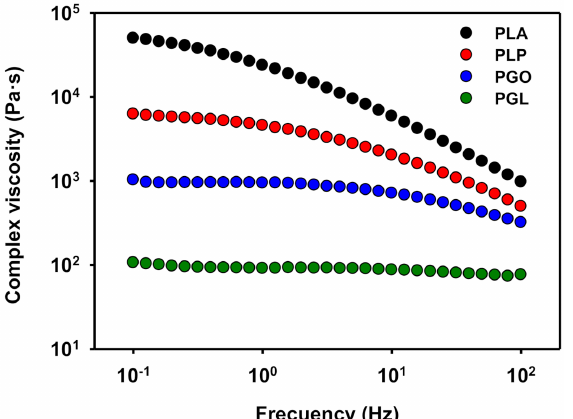
Figure 10. Representation of complex viscosity at 130 ◦ C for PLA, PLP, PGO, and